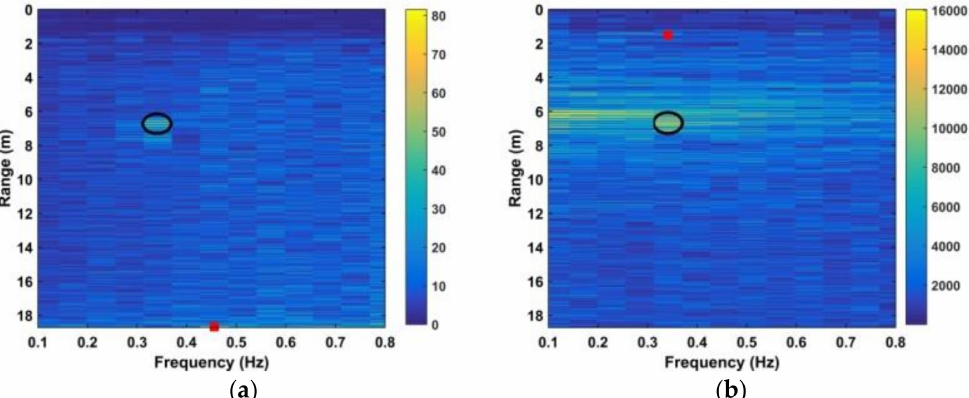
Figure 22. Results for the actuator experiment at 700 cm using ( a ) AM method, and ( b ) CFAR